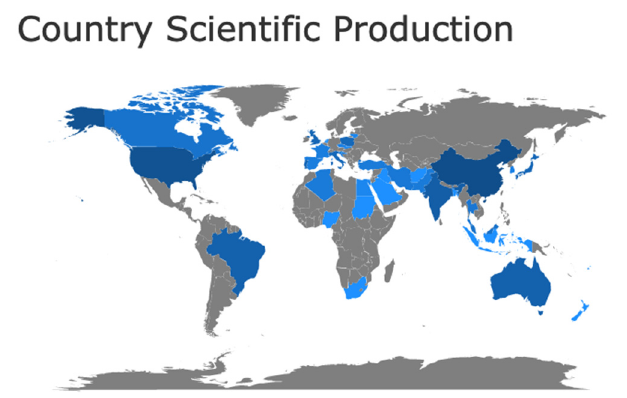
Figure 2. Countries’ scientific production on geosyinthetics research entrenched with managerial implications, as considered in this study. The most productive countries have the darkest blue, the least productive have the lightest blue, while grey is for non-productive countries.